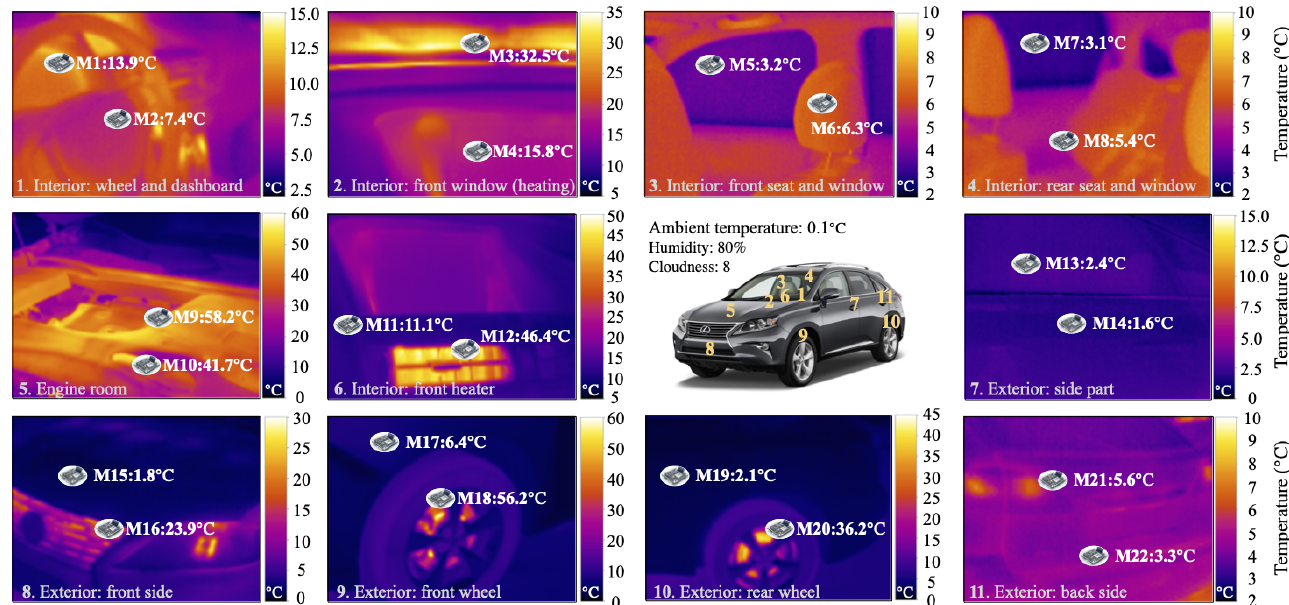
Figure 2. An example of the thermal distribution of a car: the car is divided into 11 parts and each thermal image of the part is taken with an infrared camera. The weather condition is reported in the middle of the figure, and each image includes the temperature information of two specific